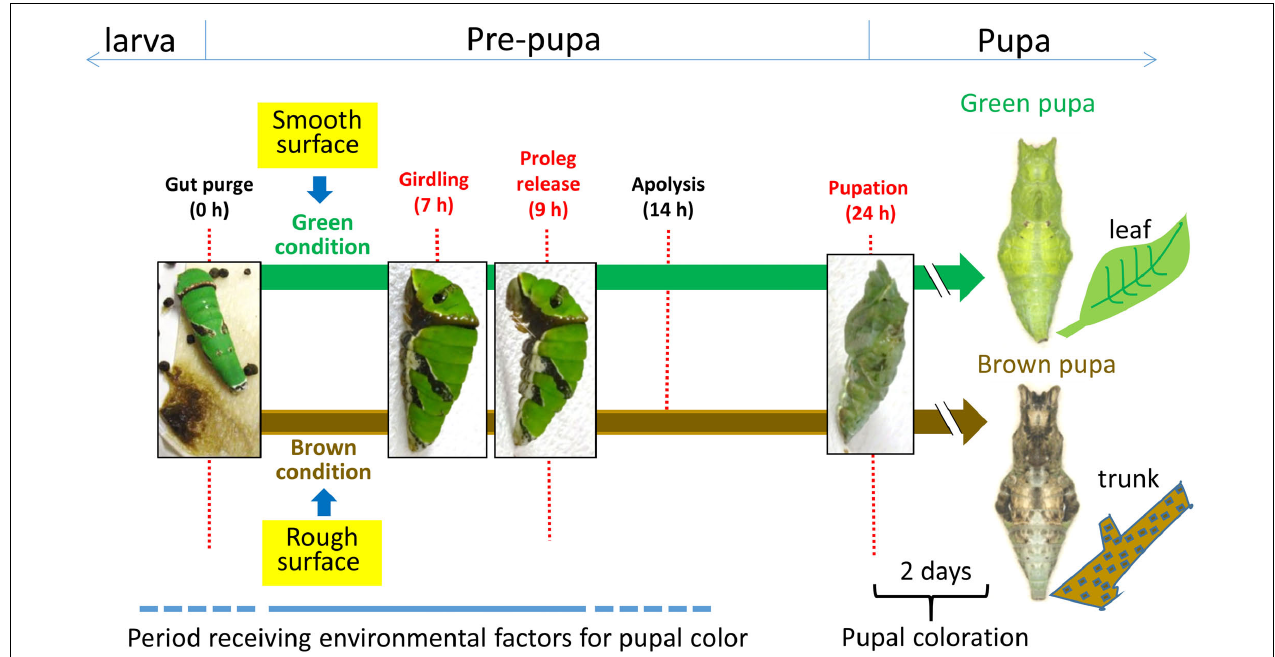
FIGURE 1 | Developmental process of dimorphic pupal color formation in Papilio butterfly. It is hypothesized that the protective pupal body color is pre-determined in response to environmental factors, mainly tactile stimuli (smooth surface stimulus for a green color and rough surface stimulus for a brown color), after gut purge until the abdominal proleg is released during the pre-pupal stage. If the timing of gut purge is set as 0 h, band formation (girdling) occurs about 7 h later, proleg release about 9 h later, and pupation about 24 h later. The pupal coloration starts after pupal ecdysis and is completed by 2 days after